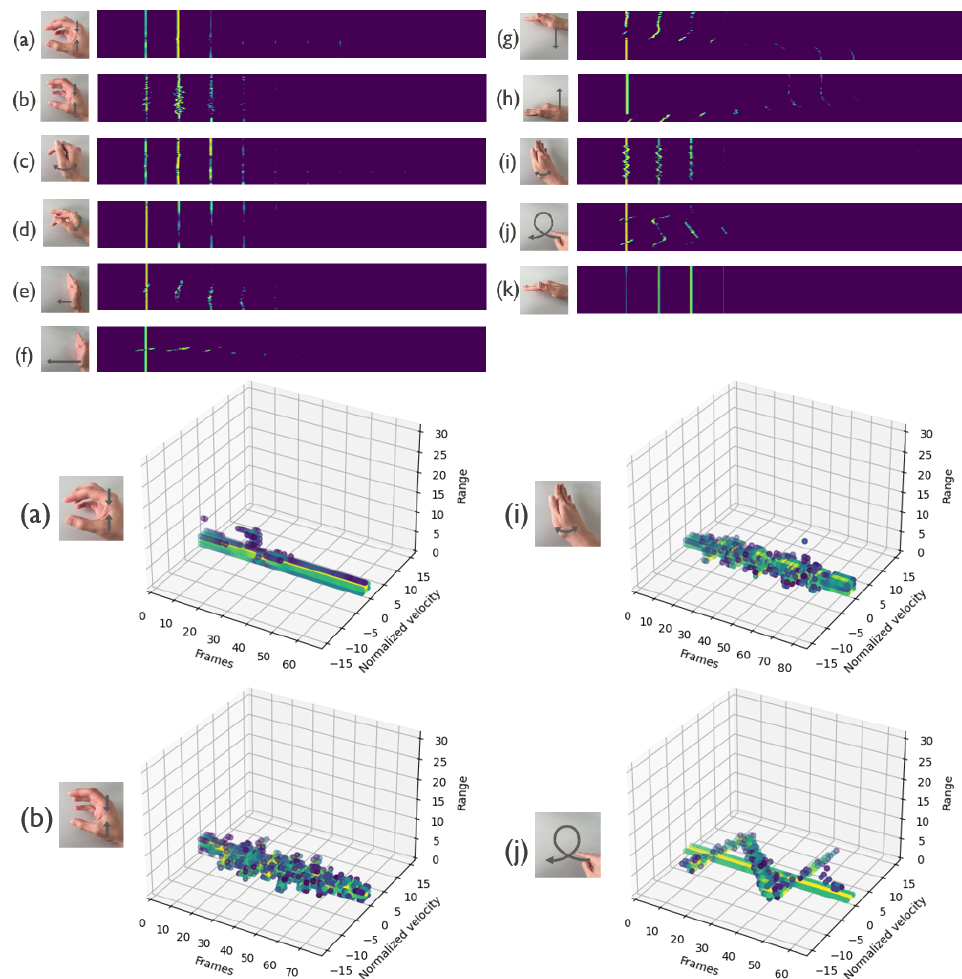
Figure 6. Soli Gestures: sample of 11 gestures with their respective pixel vs. frame capped image. ( a ) Pinch Index, ( b ) Pinch Pinky, ( c ) Finger Slide, ( d ) Finger Rub, ( e ) Slow Swipe, ( f ) Fast Swipe, ( g ) Push, ( h ) Pull, ( i) Palm Tilt, ( j ) Circle, ( k ) Palm Hold. Figures at the lower part show the 3D image of the range-Doppler frames for four